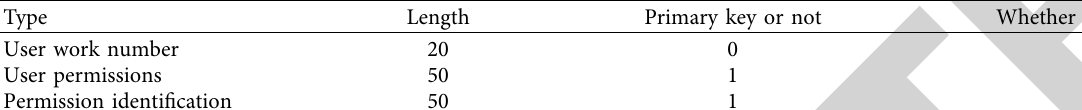
Table 4: Basic information about user rights.